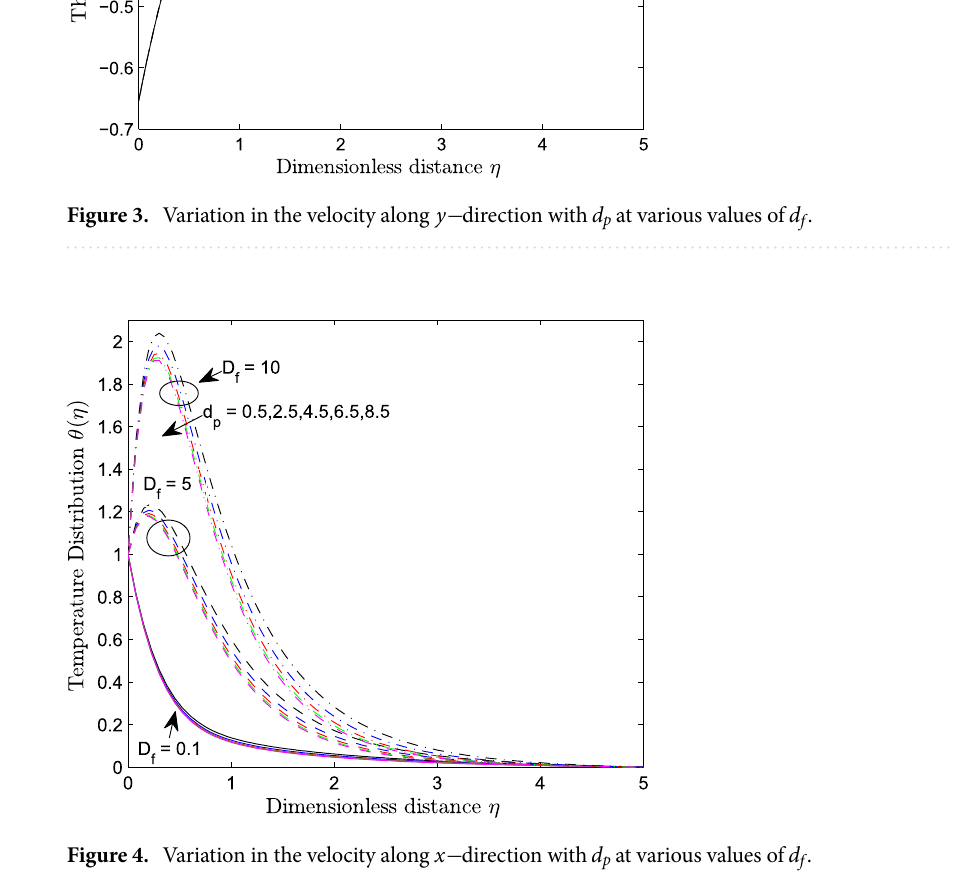
Figure 4. Variation in the velocity along x